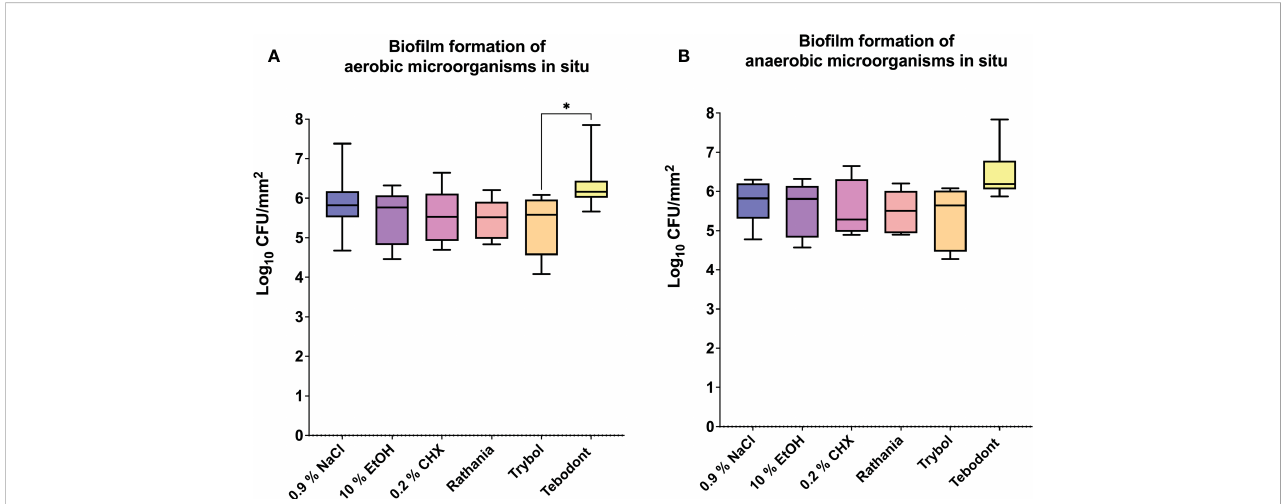
FIGURE 4 The graphs show the number of CFUs that demonstrate the antimicrobial effect of the tested substances on aerobic (A) and anaerobic (B) bacteria after an oral exposure time of 72 hours. A positive control (0.2% CHX), two negative controls (0.9% NaCl, 10% EtOH) and three different natural mouthrinses Ratanhia, Trybol and Tebodont were also used. The CFU values were shown on a log 10 scale per mm 2 (log 10 /mm 2 ). The horizontal line within the box shows the median values. The p-values of the signi fi cantly different data are plotted: *= P-value <0.05.